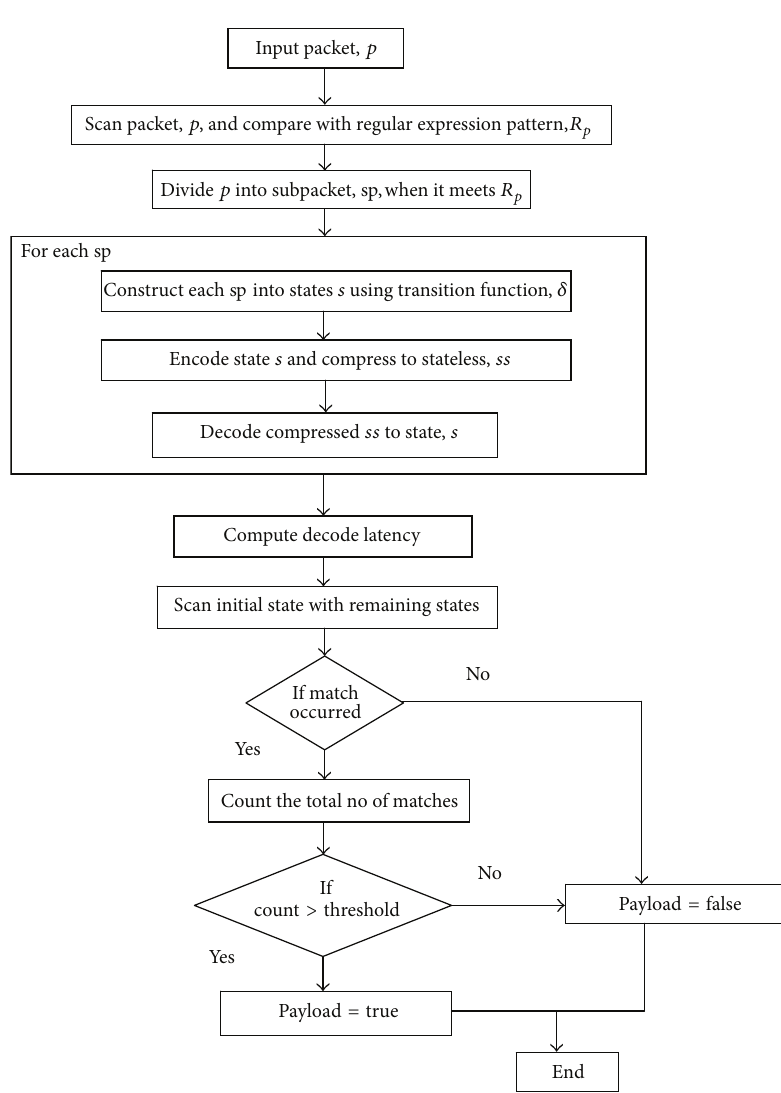
Figure 6: Flowchart for proposed